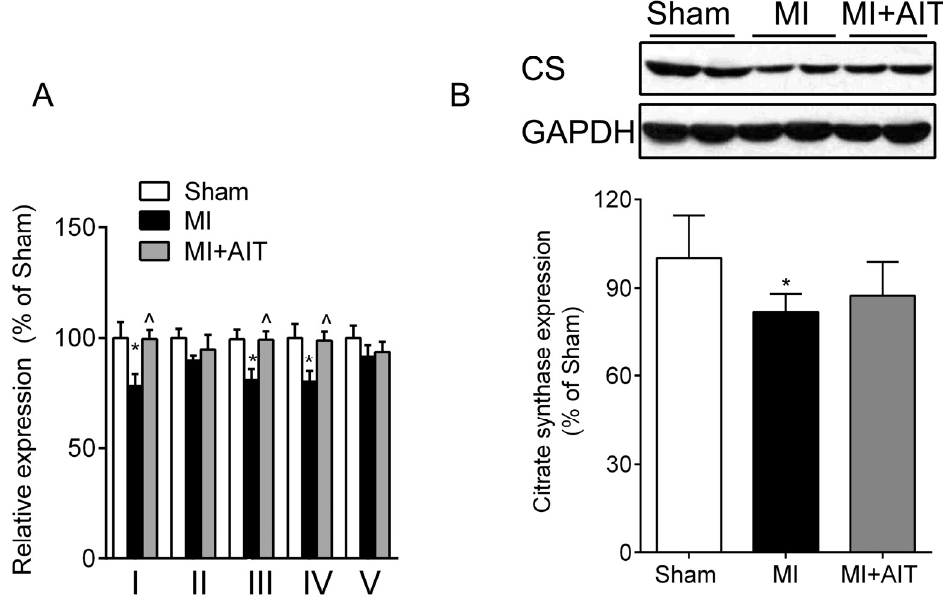
Figure 4. Effects of MI and AIT on mitochondrial electron transport chain (ETC) complex activities and citrate synthase. After 8 weeks, the rats were killed, and ETC complex activities and citrate synthase were assessed. ( A ) ETC complex activities; ( B )